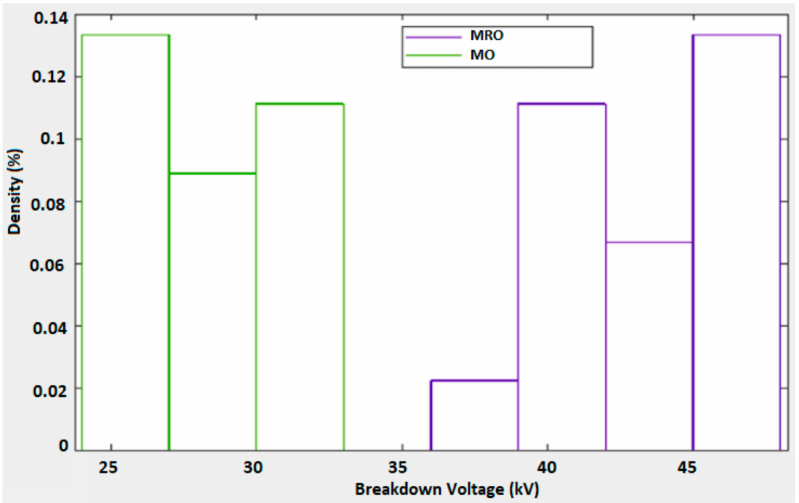
Figure 1. Showing the different ranges of breakdown voltage at which, the MRO and MO have its % density.